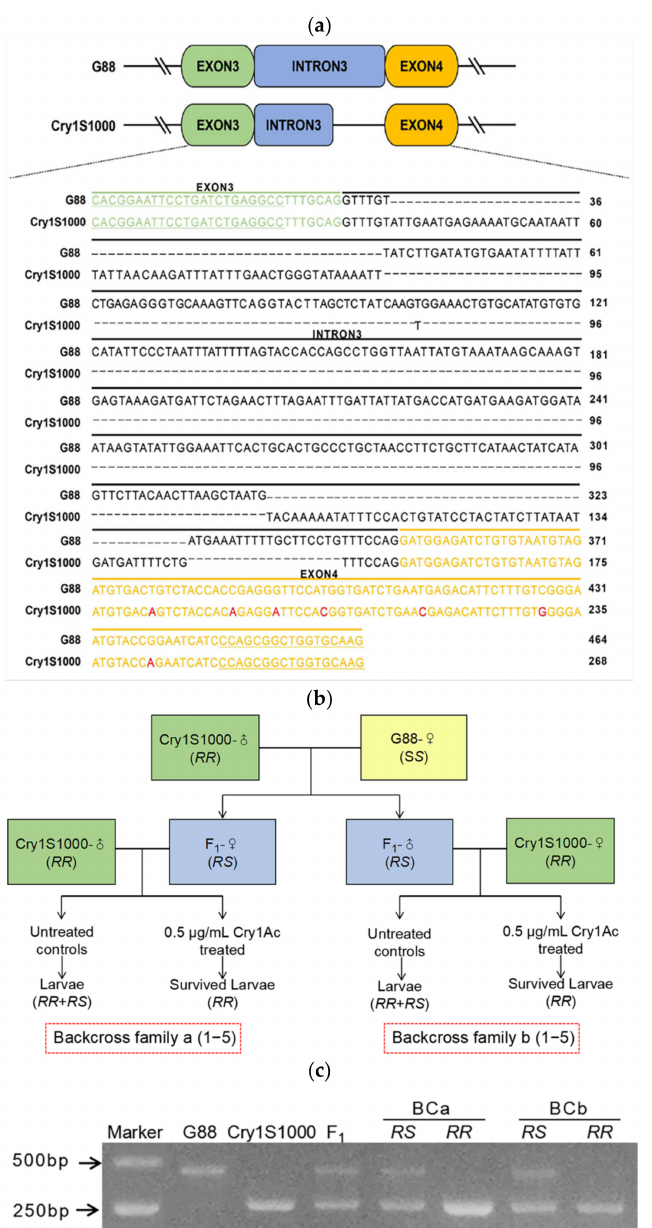
Figure 4. Genetic linkage of PxMetAP1 with Cry1Ac resistance. ( a ) Allelic sequence alignment of PxMetAP1 gene in G88 and Cry1S1000 strains. The sequences highlighted in green and orange are the exon 3 and 4 regions, respectively, the underlined sequences are the forward and reverse complementary primers that specifically verify the intron lengths of the different genotypes of PxMetAP1 , and the red bases represent the point mutation in exon 4. ( b ) Diagram illustrating the strategy for back-crossing and toxicity bioassays. The F 1 generation is produced by the single-head pairing of G88 ( SS ) female adults and Cry1S1000 ( RR ) male adults. BCa1–5 is produced by the single- pair mating of the F 1 generation ( RS ) female adults with the Cry1S1000 male adults, and BCb1–5 is produced by the single-pair mating of the F 1 generation ( RS ) male adults with the Cry1S1000 female adults. The surviving individuals in the control group are RR and RS , and the surviving individuals in the treatment group (0.5 µ g/mL Cry1Ac protoxin) are RR; ( c ) genotypes of the PxMetAP1 gene in G88 ( S M1 S M1 ) and Cry1S1000 ( R M1 R M1 ) strains and in the F 1 generation ( R M1 S M1 ) generated by